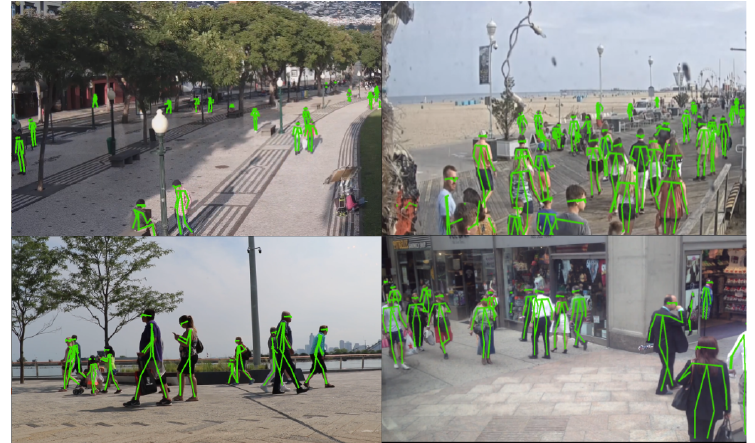
Figure 1. Samples from the UWG dataset. We gather skeleton sequences by applying state-of-the- art pose estimation/pose tracking models on publicly available surveillance streams. This allows for learning discriminative gait representations without explicit human labels and without the cooperation of